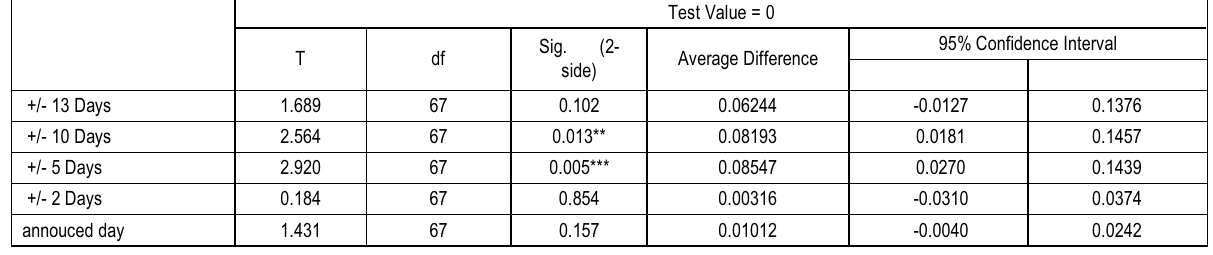
Table no. 2. Statistics for reverse stock